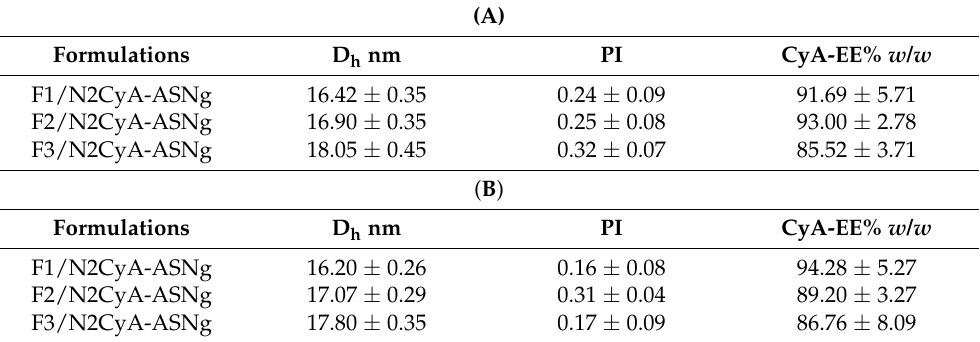
Table 8. Storage stability of Fx/CyA-ASNg at ( A ) 4 ◦ C and ( B ) room temperature over 60 days (mean ± SD, n =